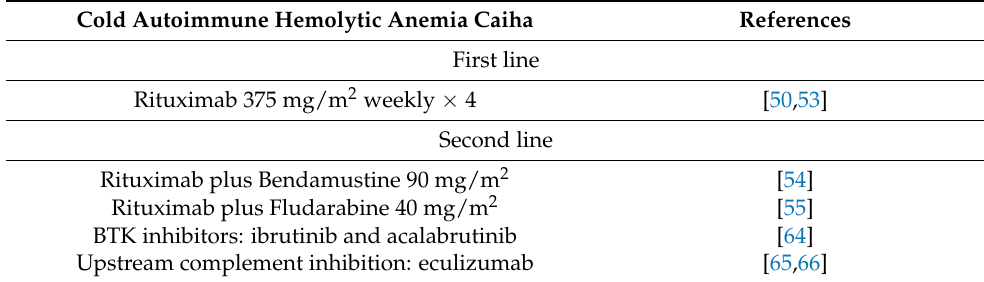
Table 3. Options for treatment of